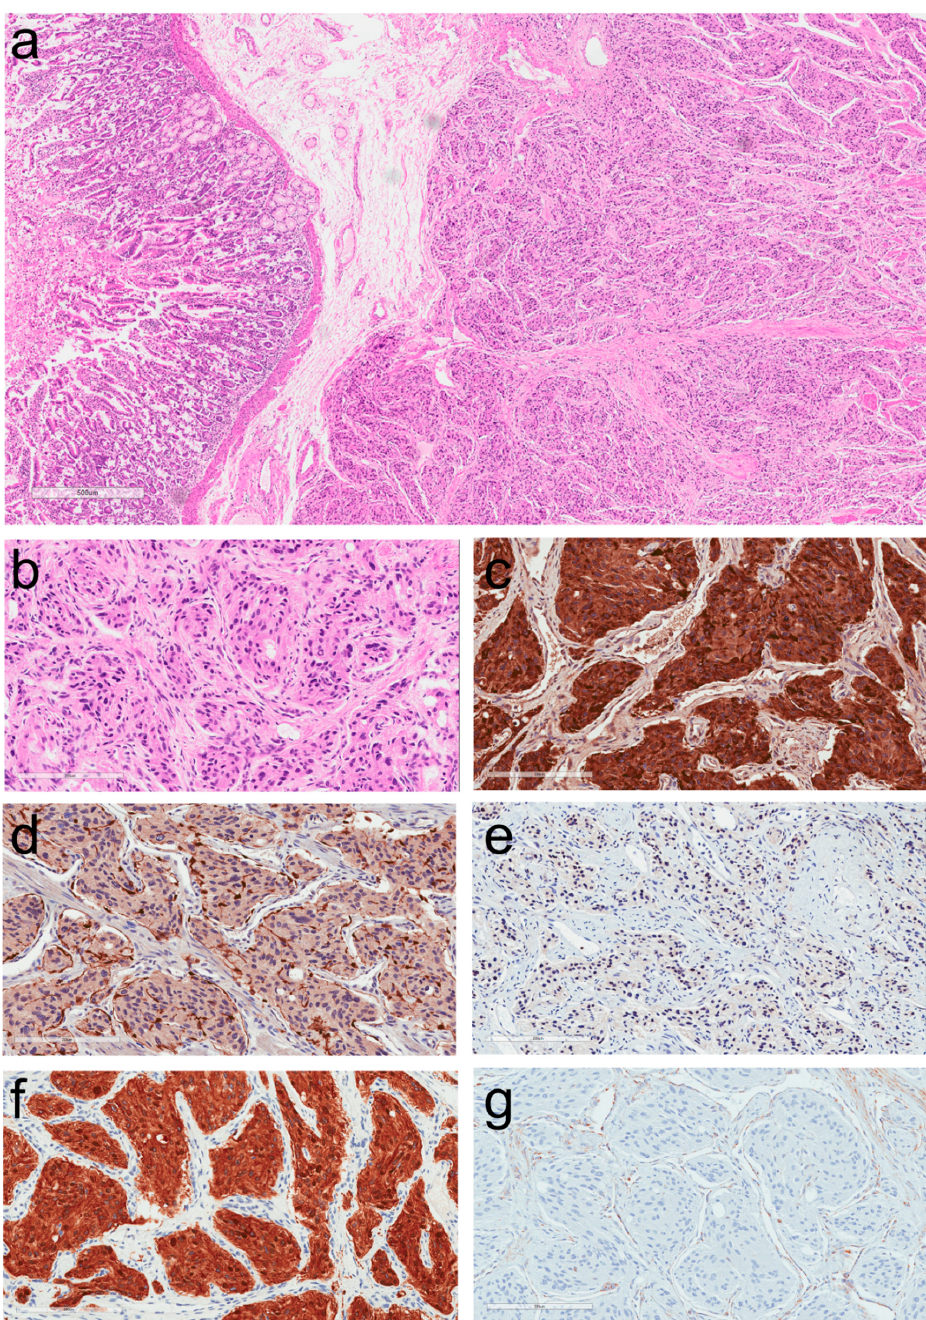
Figure 3. Histology and immunoprofile of a duodenal Succinate Dehydrogenase (SDH)-deficient paraganglioma. ( a ) This tumor is identified underlying duodenal mucosa and was classified as a small bowel neuroendocrine tumor. ( b ) The tumor cells are form small nests within a fibrovascular stroma. They are somewhat elongated and have moderate nuclear pleomorphism. ( c ) The tumor is strongly positive for chromogranin-A. ( d ) Sustentacular cells are highlighted by their intense reactivity for S100 protein. ( e ) There is nuclear staining for GATA-3 in tumor cells. ( f ) Strong cytoplasmic positivity for tyrosine hydroxylase confirms the diagnosis of paraganglioma. ( g ) This tumor is SDH-deficient as shown by lack of cytoplasmic granular reactivity for SDH subunit B (SDHB); note the positivity in stromal cells that serve as an internal